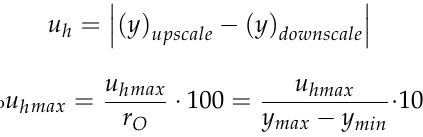
(b) Figure 12. Capacitance change of the air-gap touch sensor during the repeated application of force: (a) switching of the input force; and (b) result of 10 time repetition of the switching process At the first cycle, the average  C / C was 0.1861% when the force of 1 N was applied, and 0.0054% when the force was released. At the tenth cycle, the average  C / C was 0.1869% when the same force